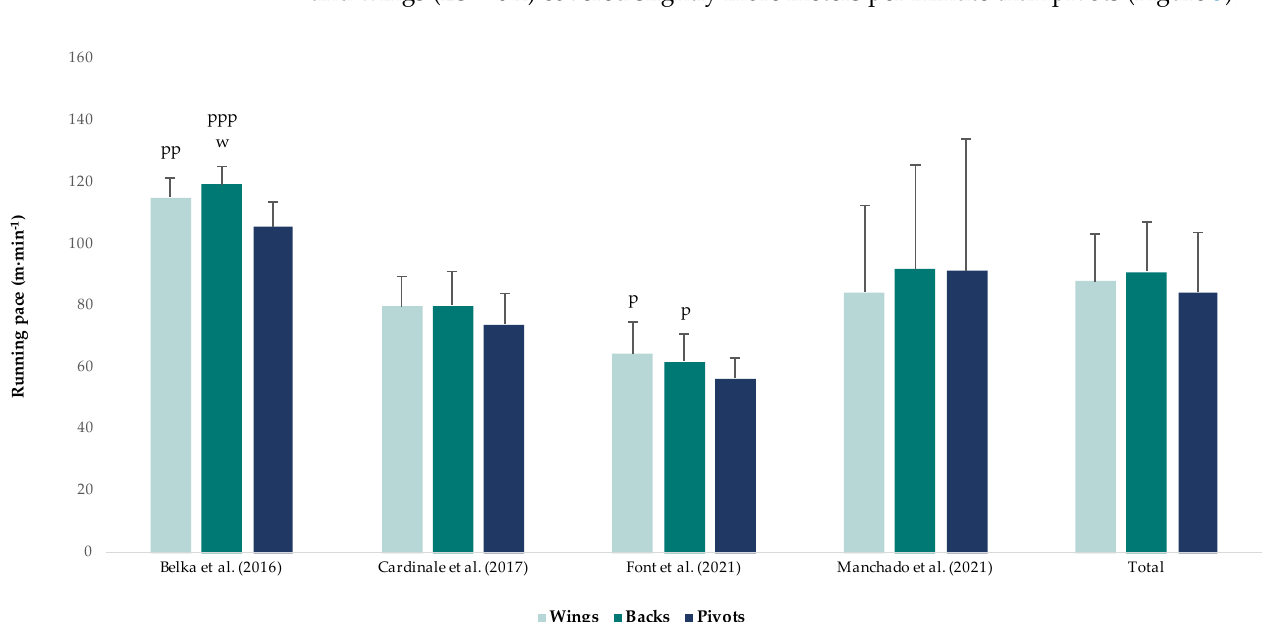
Figure 5. Running pace according to playing positions. The magnitude of the standardised differences (effect size) between the different positions is indicated by the number of symbols: one symbol stands for a moderate difference, two for a large difference, three for a very large difference. B stands for substantial difference vs. backs, w vs. wings and p vs. pivot [10,12,15,40]. Font et al. [15] found that handball players performed more than 1000 accelerations and decelerations during a game [15], and Luteberget et al. [13] found an average of 3.9 ± 1.5 high-intensity events per minute (sum of the ACC, DEC and COD greater than 2.5 m · s − 2 ). Wings, backs and pivots performed a similar number of accelerations and decelerations [15]. However, high-intensity accelerations (HIA) and high-intensity deceler- ations (HID) were different between playing positions [15]. Wings (134.8 ± 60.7) performed slightly more HIA than backs (128.1 ± 55.2) and pivots (112.0 ± 33.6) (ES = 0.12 and 0.46, respectively); in contrast, backs (114.6 ± 51.77) performed a similar number of HID than wings (112.9 ± 56.0) and slightly more than pivots (99.6 ± 28.9) (ES = 0.03 and 0.3,